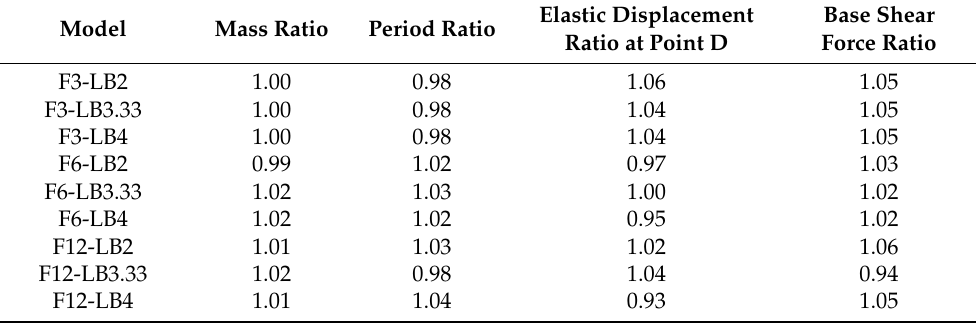
Figure 9. In-plane deformation of diaphragm. Table 3. Calculation results comparisons of response spectrum case between ETABS and PKPM.